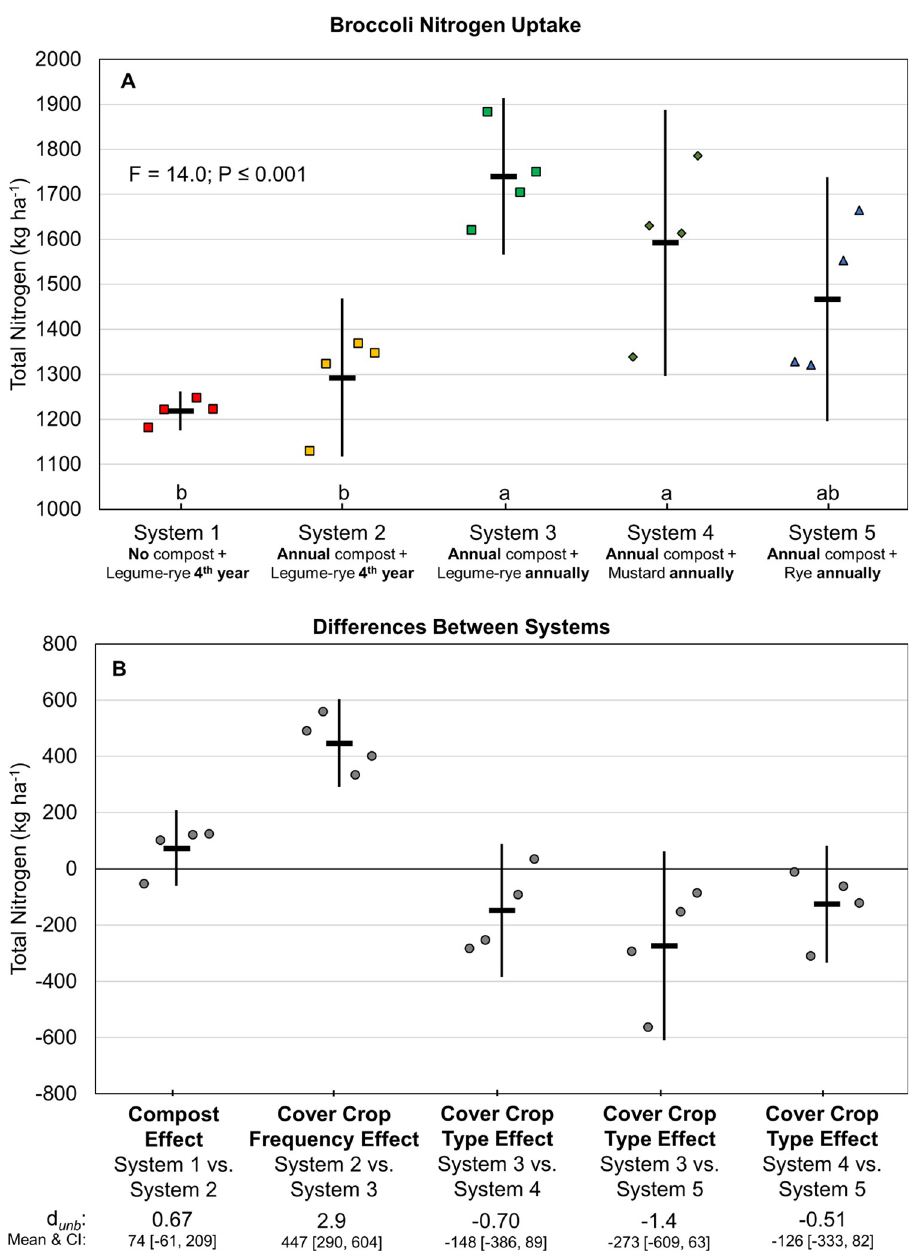
Fig 7. Cumulative above ground and estimated below ground broccoli nitrogen uptake over six years of vegetable production. Mean cumulative nitrogen uptake (A) and mean paired differences between systems (B) in 5 organic vegetable systems. Systems differed by annual compost additions, cover crop type and cover cropping frequency. Error bars are 95% confidence intervals (CI) around the mean (horizontal line). Data points are replicates 1 through 4 averaged across years and are clustered around the mean left to right so as not to obscure the mean and CI. Different lower-case letters above the x-axis in plot A indicate that means are significantly different based on the Tukey-Kramer adjusted family-wise error rate of P � 0.05. The standardized effect size (Cohen’s unbiased d , d x-axis in plot B.